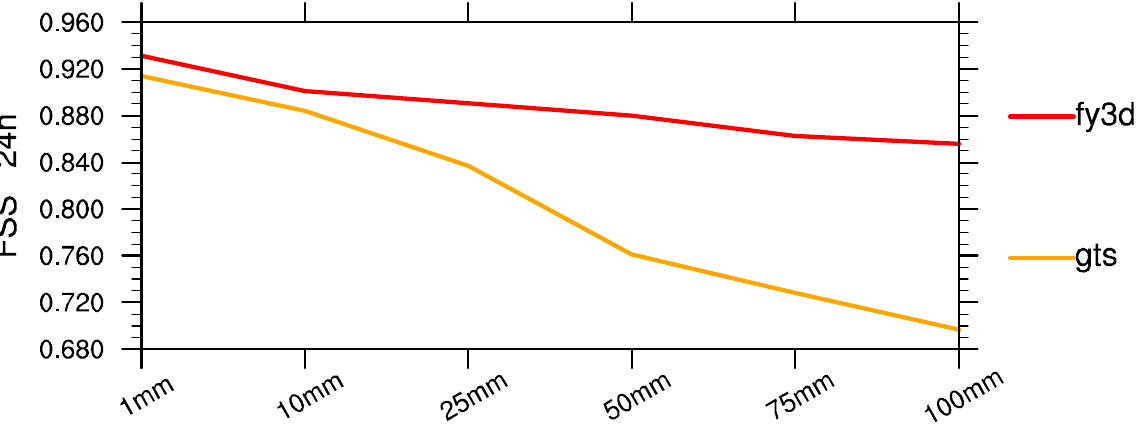
Figure 12. FSS score of GTS and MWHS2.